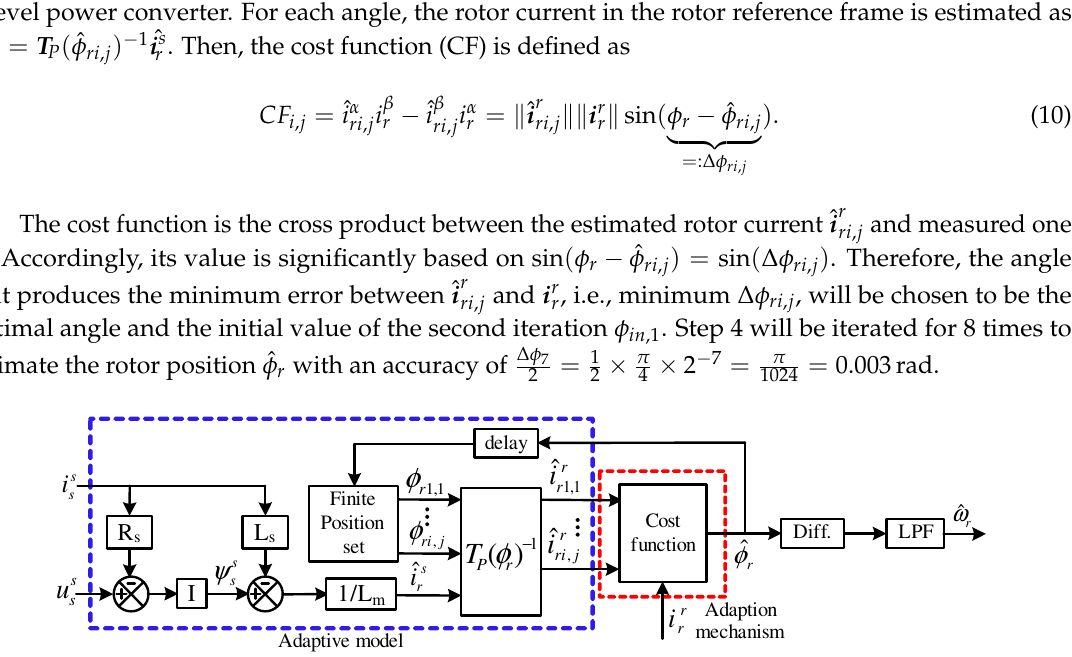
Figure 3. Block diagram of the proposed limited-position set (LPS)-MRAO for control of DFIGs without mechanical